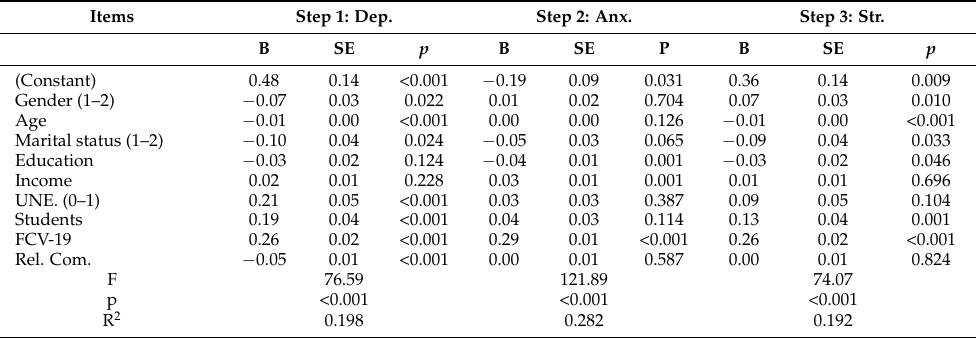
Table 3. Multiple linear regressions.